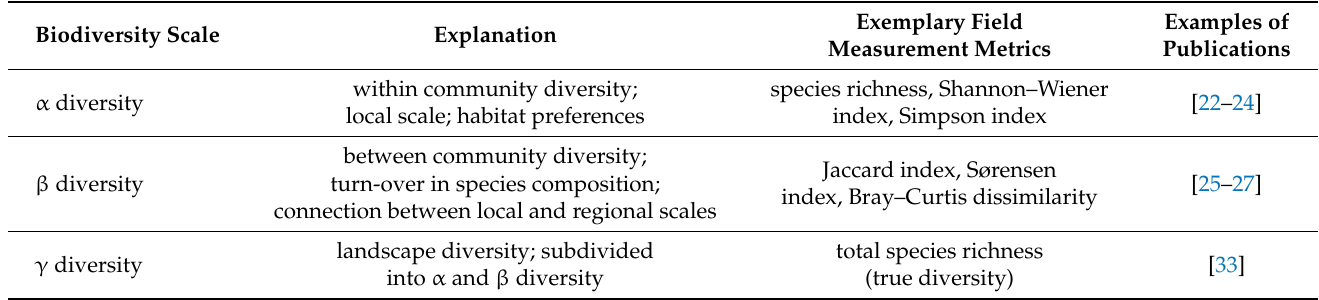
Table 1. Explanation of α , β , and γ diversity with respective field measurement